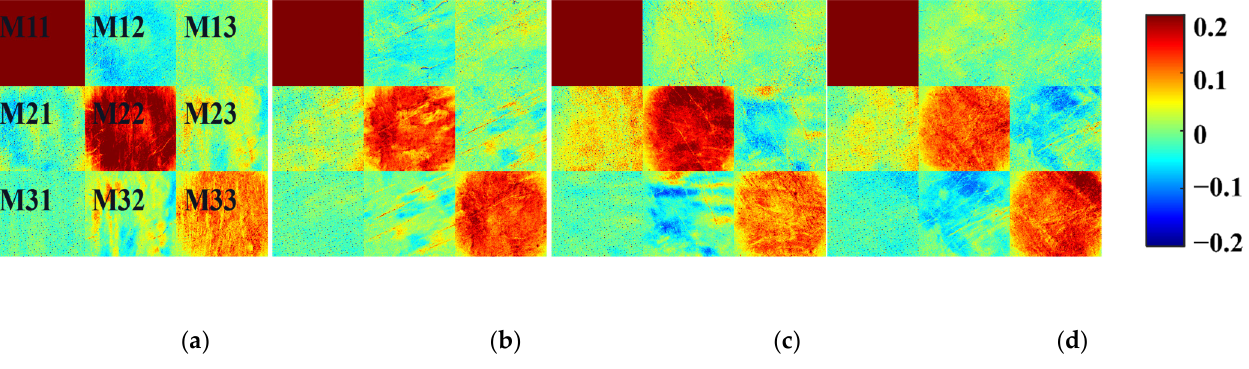
Figure 2. Two-dimensional (2D) backscattering 3 × 3 Mueller matrix images of bovine tendon tissue samples: ( a ) without stretching (origin), ( b ) transverse stretching (TDO), ( c ) longitudinal stretching (MDO), and ( d ) 45 deg stretching (ODO). All the Mueller matrix elements are normalized by the M11. The color bar is from − 1 to 1 for the M11, − 0.2 to 0.2 for the M22 and M33 and from − 0.1 to 0.1 for other elements. It should be noted that the self-normalized M11 is polarization irrelevant.